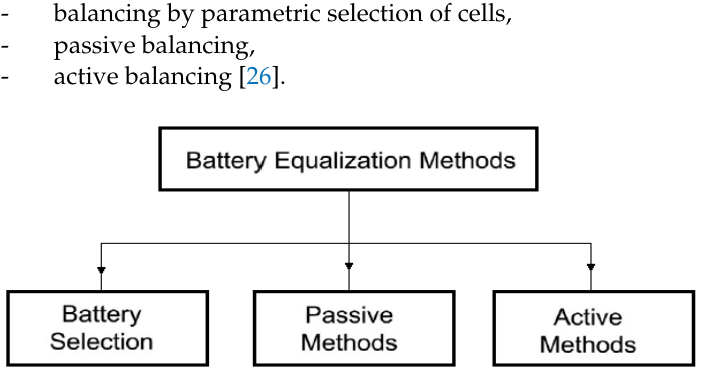
Figure 1. Cell balancing methods.